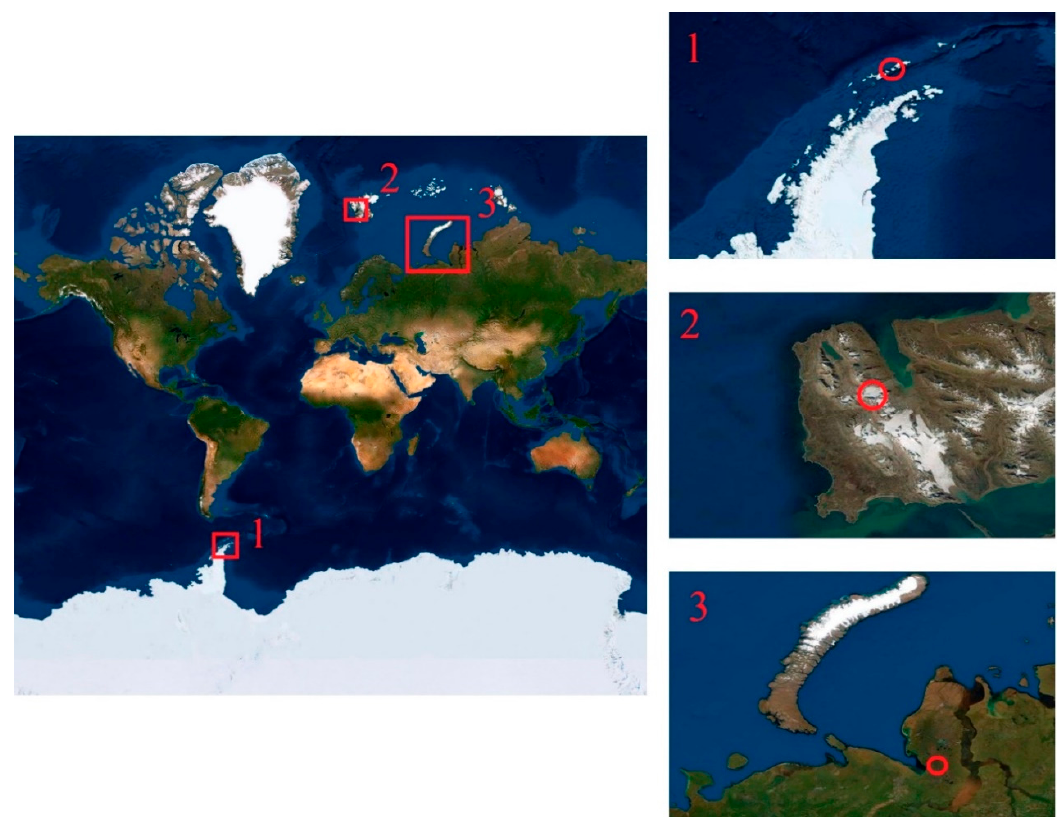
Figure 1. The study area. ( 1 ) King-George, Antarctica; ( 2 ) Grønfjorden area, Spitsbergen; ( 3 ) Yamal Figure1. Thestudyarea. ( 1 )King-George,Antarctica;( 2 )Grønfjordenarea,Spitsbergen;( 3 )Yamalpeninsula. peninsula. Table 1. Climate parameters of study